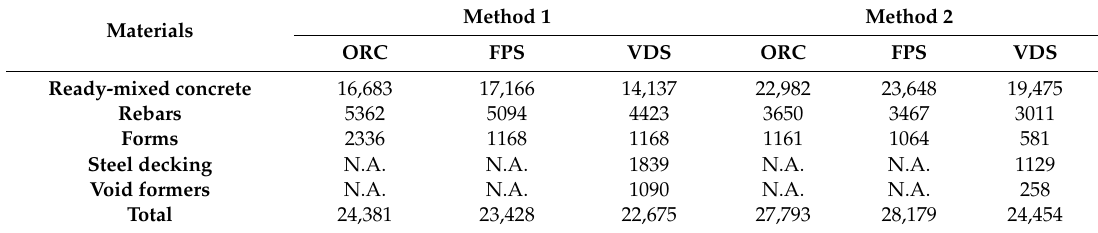
Table 9. Emissions of carbon dioxide for transporting building materials (unit: kg CO 2 eq.).